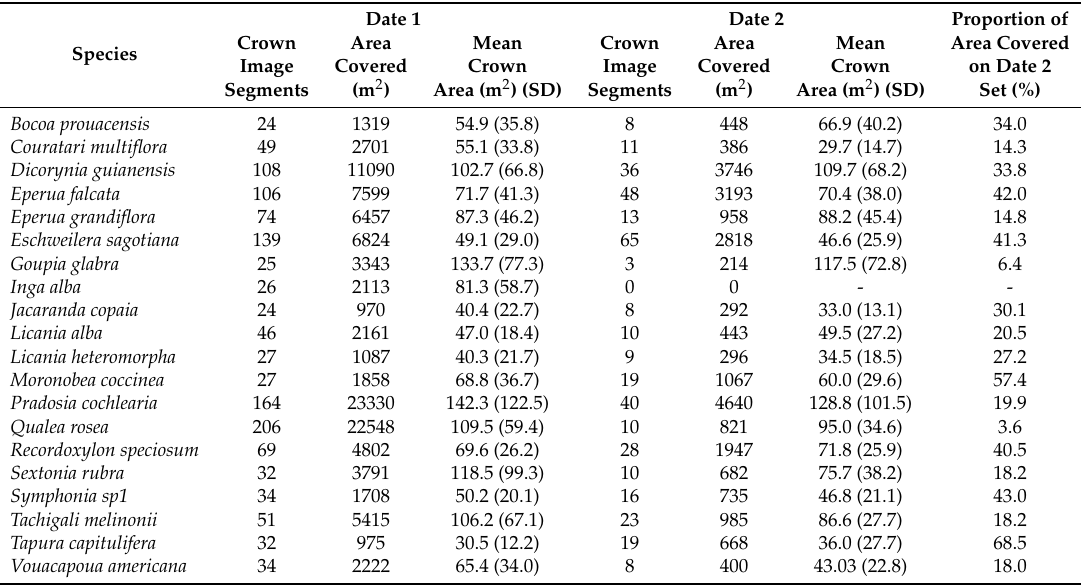
Table 1. List of species used and their associated crown and pixel numbers. The entire site was covered on date 1 and a subset was imaged again on date